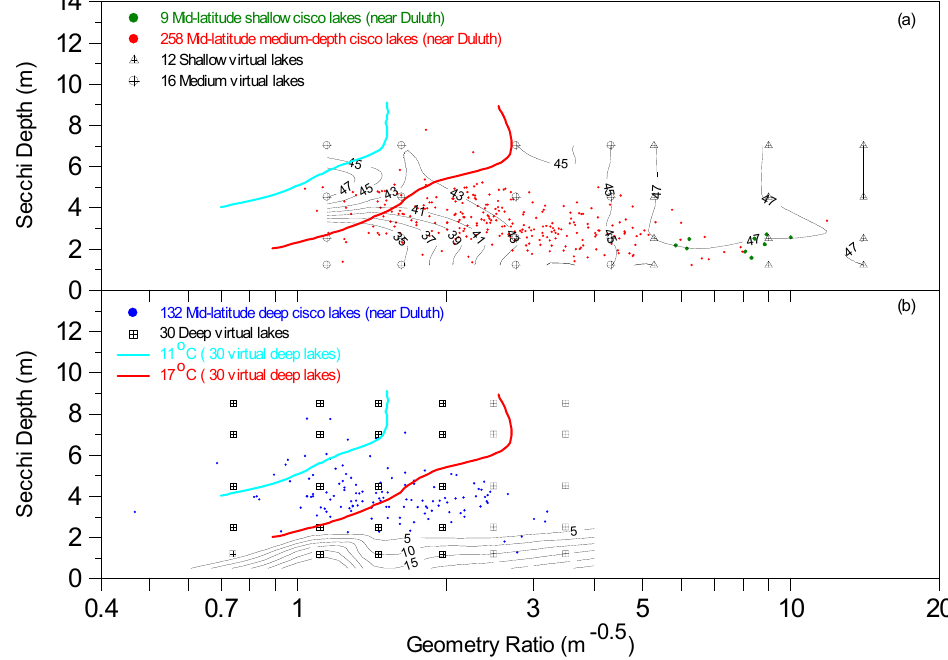
Figure 4. Contour plots of a total number of years with cisco kill under future MIROC3.2 climate scenario from Jiang and Fang’s study [11]. Duluth weather data were used for model simulations, and contours were derived by interpolation from simulated points for ( a ) 12 shallow and 16 medium-depth virtual lakes, and ( b ) 30 deep virtual lakes. The 11 and 17 °C contours of AvgATDO3 VB from Jiang et al. [10] are included. The simulation results in the first year 1961 were not used to extract TDO3 to avoid possible effects of initial conditions used in MINLAKE2010.